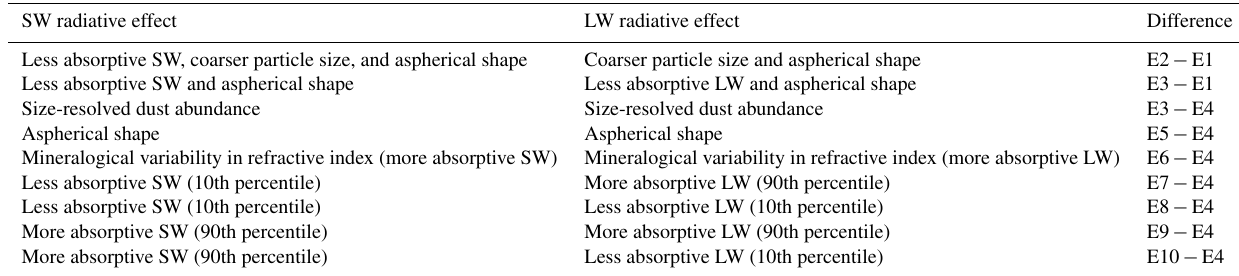
Table 2. Summary of radiative effects estimated in this